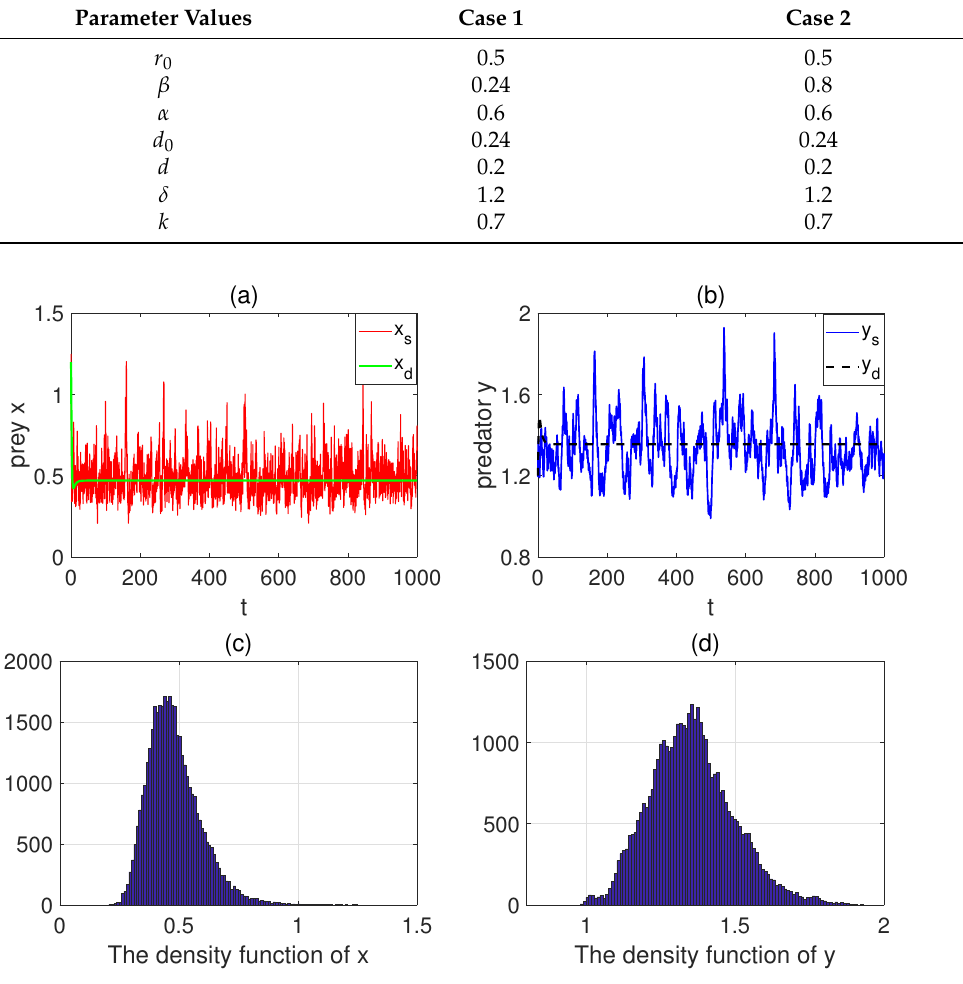
Figure 1. ( a , b ) The persistence of model ( 2 ) . ( c , d ) The probability density functions of x ( t ) and y ( t ) of model ( 2 ) .